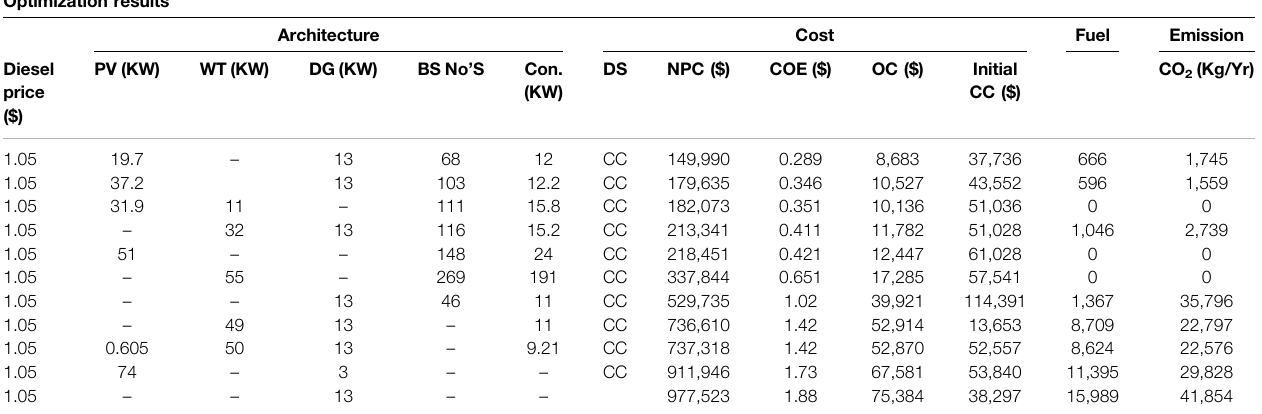
TABLE 11 | HOMER optimization results of the PV/Wind/Diesel/Battery system for Nagapattinam. Optimization results Architecture